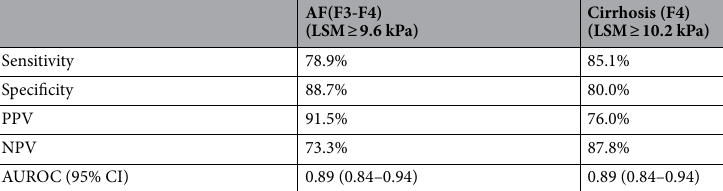
Table 2. Diagnostic performance of VCTE for advanced fibrosis and cirrhosis. AF, advanced fibrosis; AUROC, area under receiver operating characteristic curve; CI, confidence interval; LSM, liver stiffness measurement; NPV, negative predictive value; PPV, positive predictive value; VCTE, vibration controlled transient